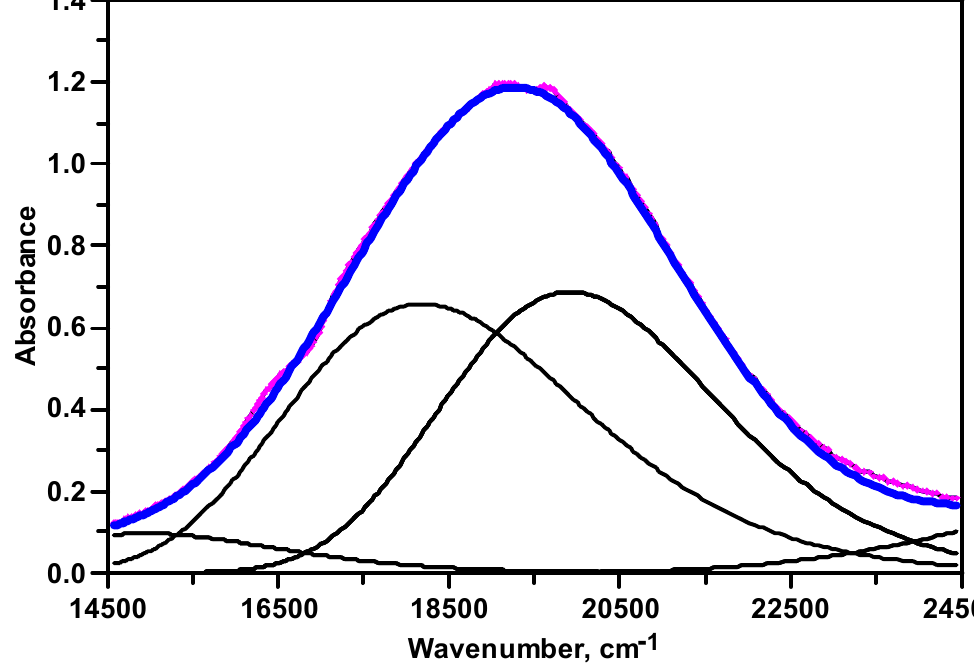
Figure 3. Visible spectrum (pink line) and resolved Gaussian curves (black line) of complex (I).